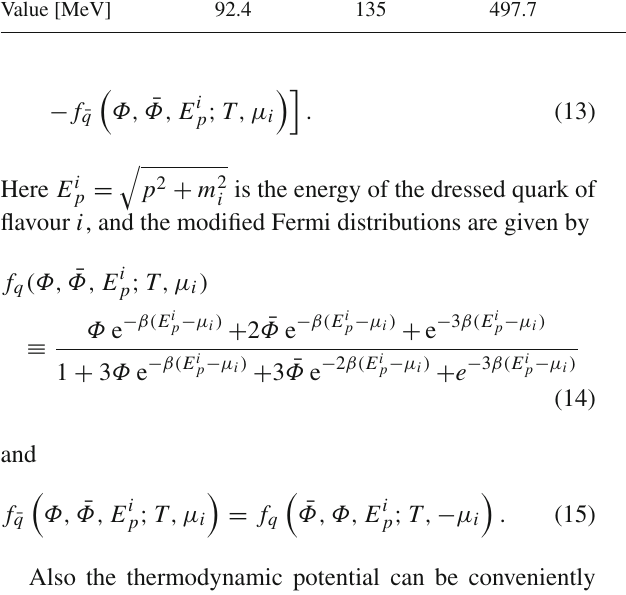
Table 3 Values of the decay constants of pseudoscalar mesons, of the meson masses and of the constituent mass of light (up and down) and strange quarks in the vacuum to which the parameters of the PQM model are adjusted to. These values are the same as in the PNJL model calculation